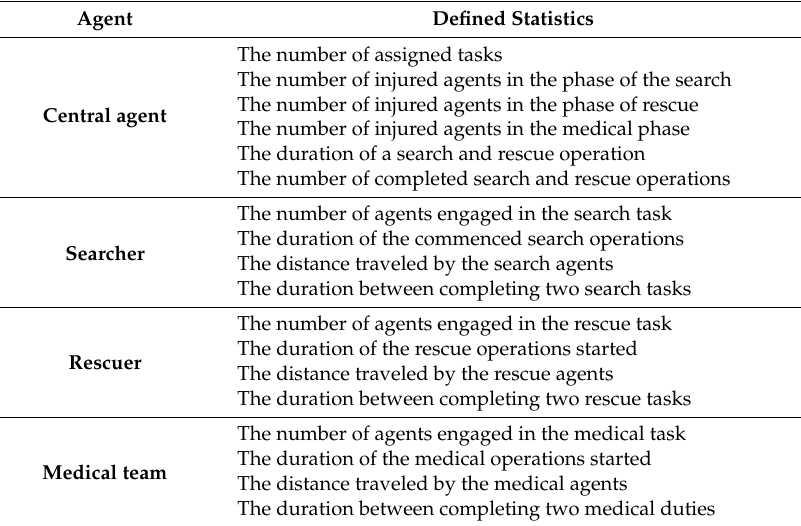
Table 4. Defined statistics for various